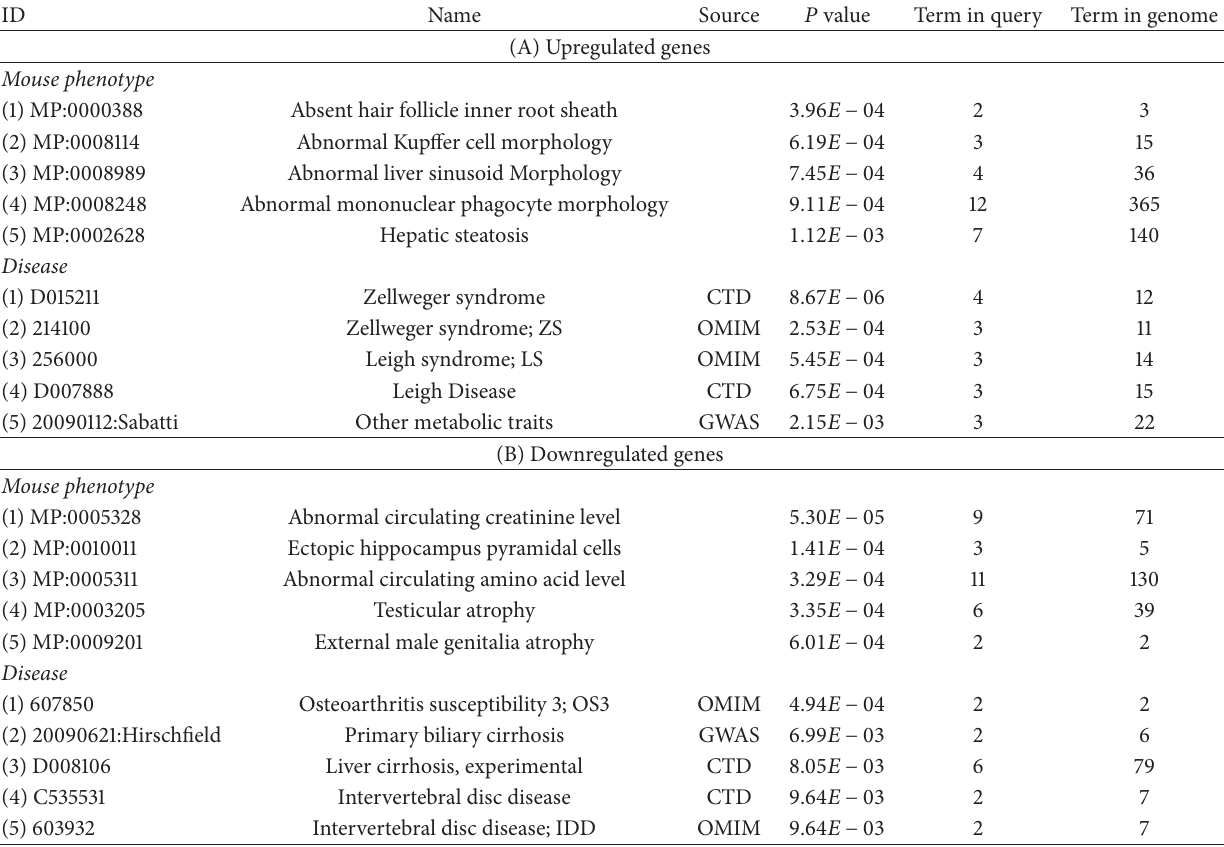
Table 6: Top terms associated with the “mouse phenotype” and “disease” functions in the liver of mice fed trans -10, cis -12-CLA using the ToppGene suite application.